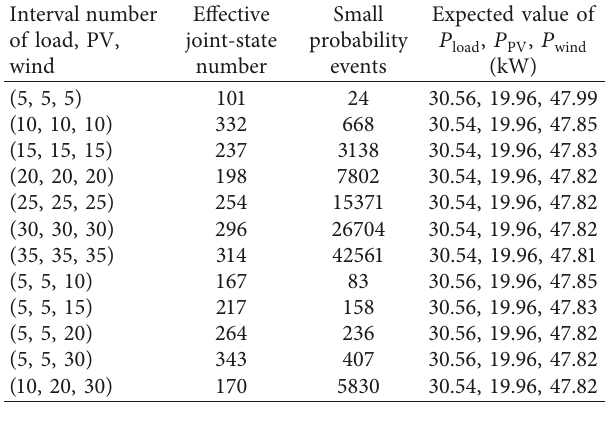
0 , 1 and N l 1 0 . 5 , 2 . Table 2: The simulation results of different interval number. ( ) ( )